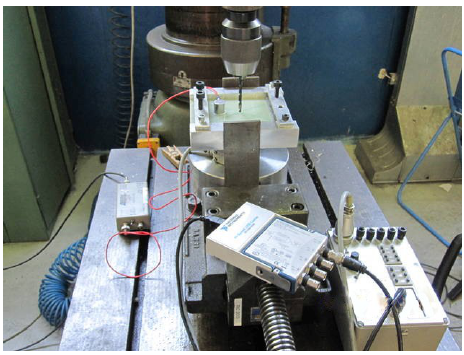
Figure 1. Experimental